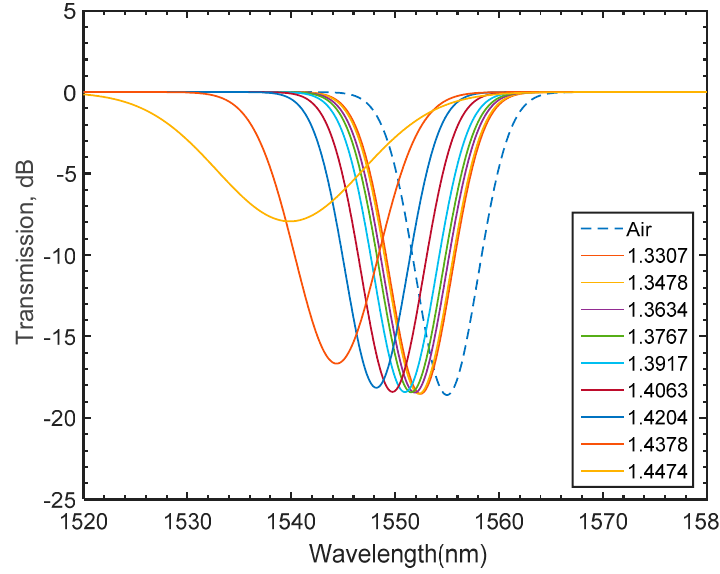
Figure 13. The numerically obtained spectral growth as a function of medium refractive index.